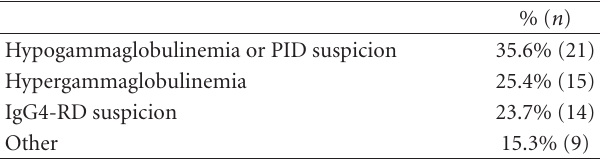
Table 1: Clinical reasons leading to IgG subclass measurement in patients with serum IgG4 elevation n = 59.